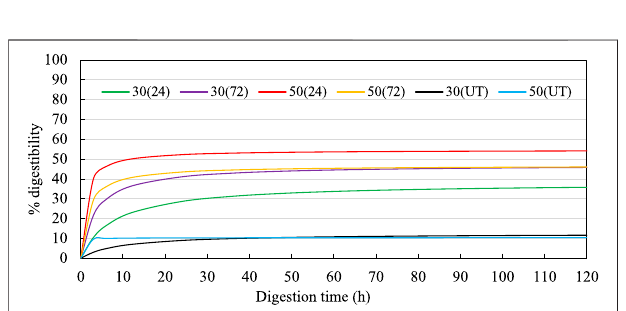
FIGURE4| EnzymaticdigestibilitycurvesfortreatedCGF.Inthelegend, the fi rst numbers indicate the MC (%db), the numbers in the parentheses indicate the incubation time (h). Hanes-Woolf linear regressions used to estimate the digestibilites over time were 30 (24): Y (cid:2) 0.0157x + 0.0248; 30 (72): Y (cid:2) 0.0164x + 0.0372; 50 (24): Y (cid:2) 0.0171x + 0.007; 50 (72): Y (cid:2) 0.0158x + 0.051; 30(UT): Y (cid:2) 0.0218x + 0.0144; 50(UT): Y (cid:2) 0.0218x + 0.0144. UT indicates untreated CGF.